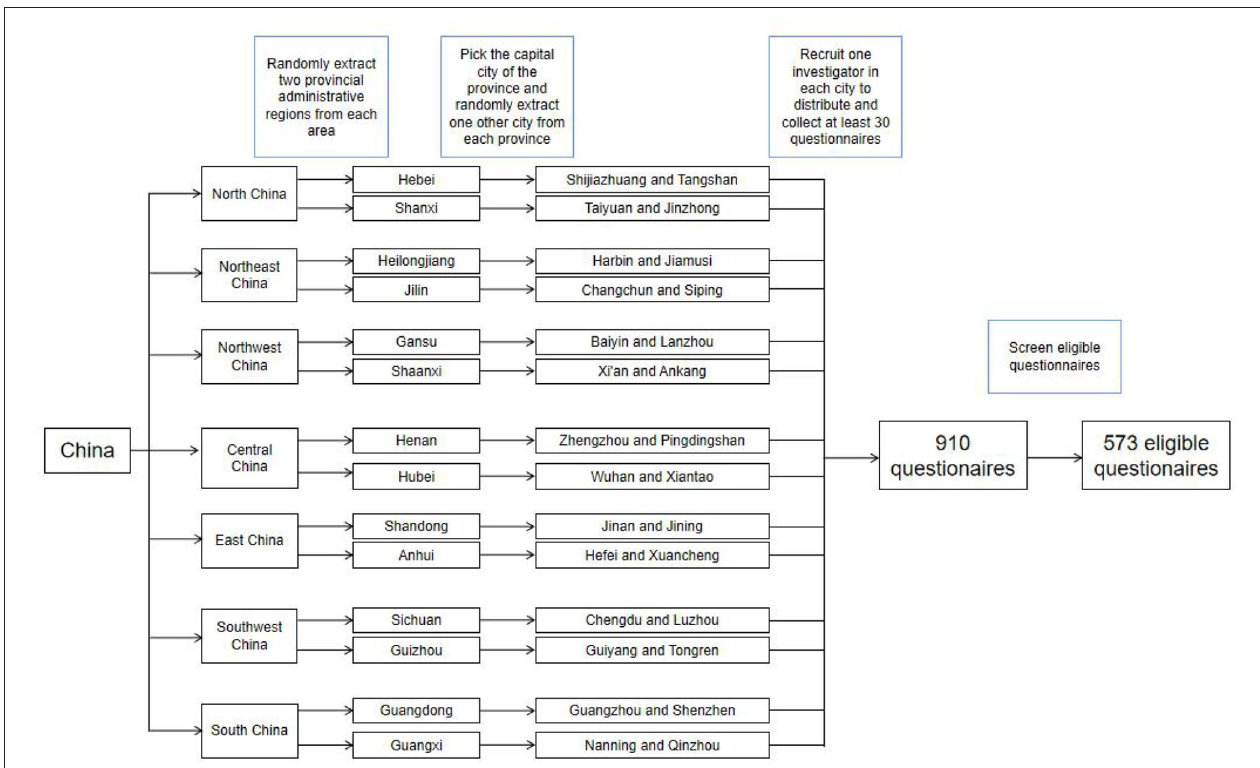
FIGURE 2 | Sampling and screening process of qualified